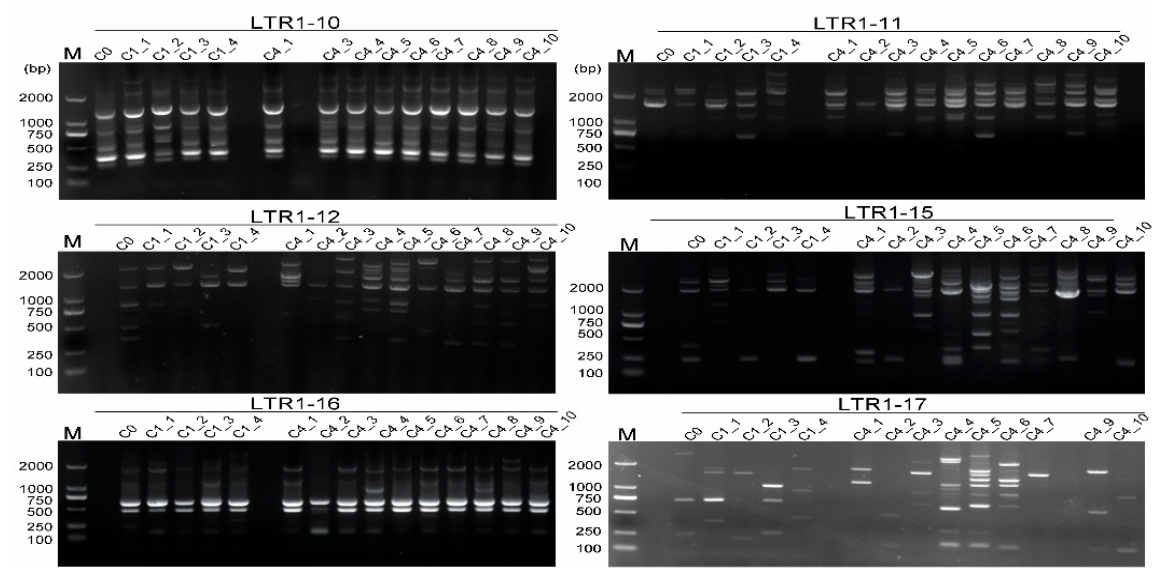
Figure 7. Detection of genetic fidelity of R. bailiense calli in somatic clones using IRAP markers. The lanes corresponding to the subclone codes are marked on the top of the gel map. Among them, C0 stands for the primary cycle; C1_1-C1_4 represent the callus from the first cycle of subculture; C4_1–C4_10 represent the materials after the forth cycle of subculture. Lanes that did not exhibit bands were retested and the binary data obtained were incorporated into subsequent analyses. M, D2000 DNA marker (Tiangen Biological Company, Beijing, China).